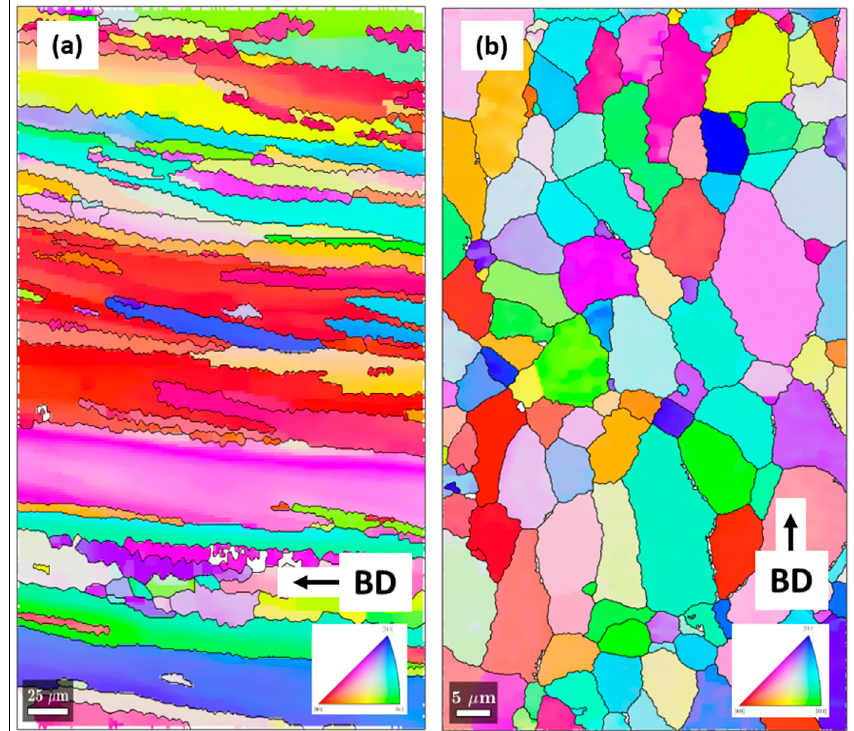
Figure 9. Electron Backscatter Diffraction (EBSD) Inverse Pole Figures (IPF) of: ( a ) 320 °C preheat-treated sample showing elongated grains along the building direction (BD) and ( b ) 500° C preheat-treated sample with a nearly equiaxed grain structure.